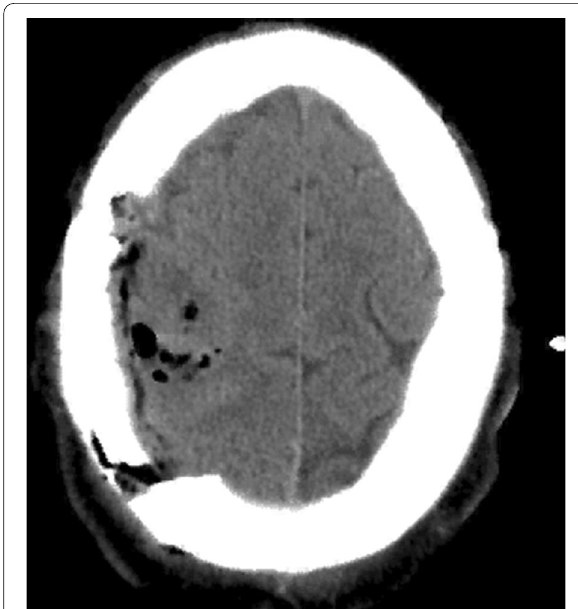
Fig. 14 CT post‑op of cavernoma case